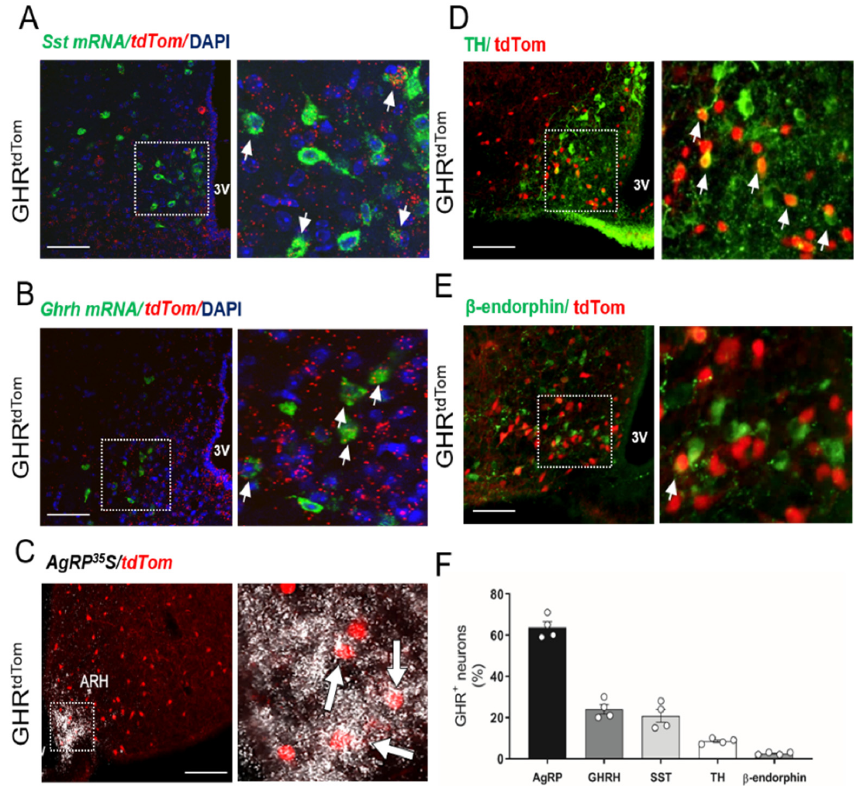
Figure 2. GHR-expressing neuron colocalization with ARC neuronal subpopulations. Two-plex fluorescent in situ hybridization of ( A ) SST mRNA (green), tdTomato mRNA (red), and DAPI (blue), and ( B ) growth hormone releasing hormone ( GHRH ) mRNA (green), tdTomato mRNA (red), and DAPI (blue). In situ hybridization of ( C ) AgRP mRNA (white) with immunohistochemistry for tdTomato (red). Immunofluorescent staining for ( D ) tyrosine hydroxylase (green) and ( E ) ß-endorphin (green) with tdTomato (red). The dashed box indicates digitally enlarged images demonstrating colocalization (white arrows). ( F ) Percentage of cells expressing targets in relation to the total amount of TdTomato + (n = 4). 3V—third ventricle. Scale bar: 100 µm.